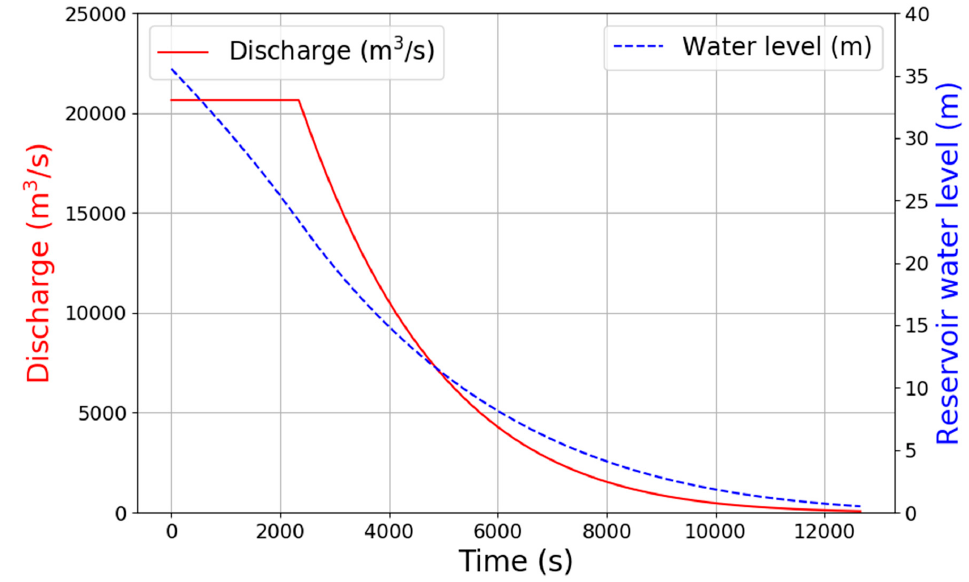
Figure 1. Predicted San Giuliano dam-break outflow hydrograph .